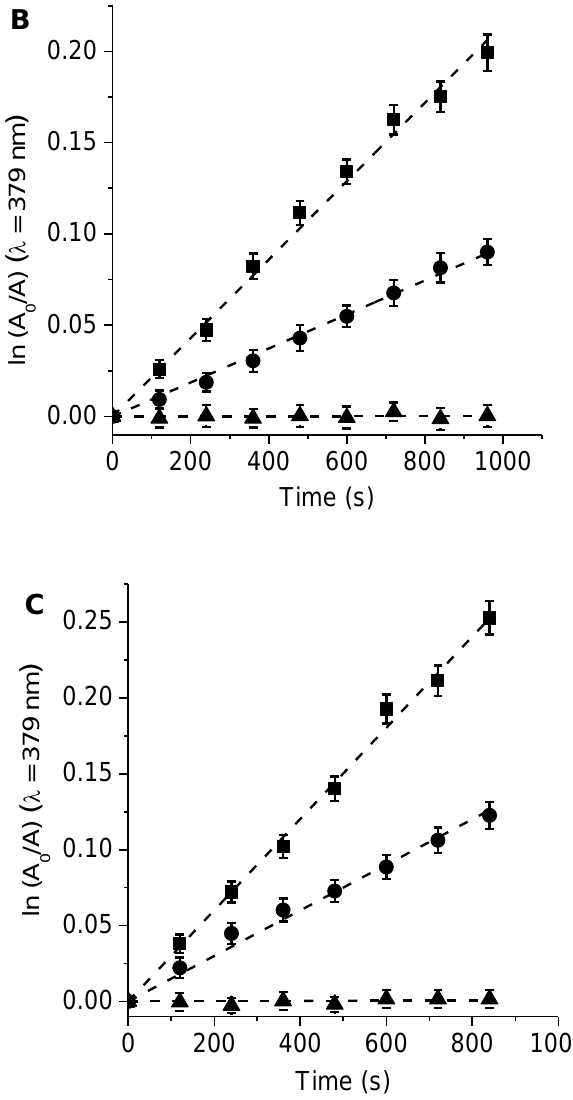
Figure 4. First-order plots for the photo-oxidation of DMA sensitized by porphyrins ( A ) 6 , ( B ) 7, and ( C ) TMP in DMF ( ■ ), DMF/5% water ( λ ), and DMF/5% water containing 50 mM KI ( π ); λ irr = 517 nm. Table 1. Kinetic parameters for the photo-oxidation reaction of DMA ( k obs DMA ) sensitized by 6 , 7 , and TMP, as well as quantum yields of O 2 ( 1 ∆ g ) production ( Φ ∆ ).